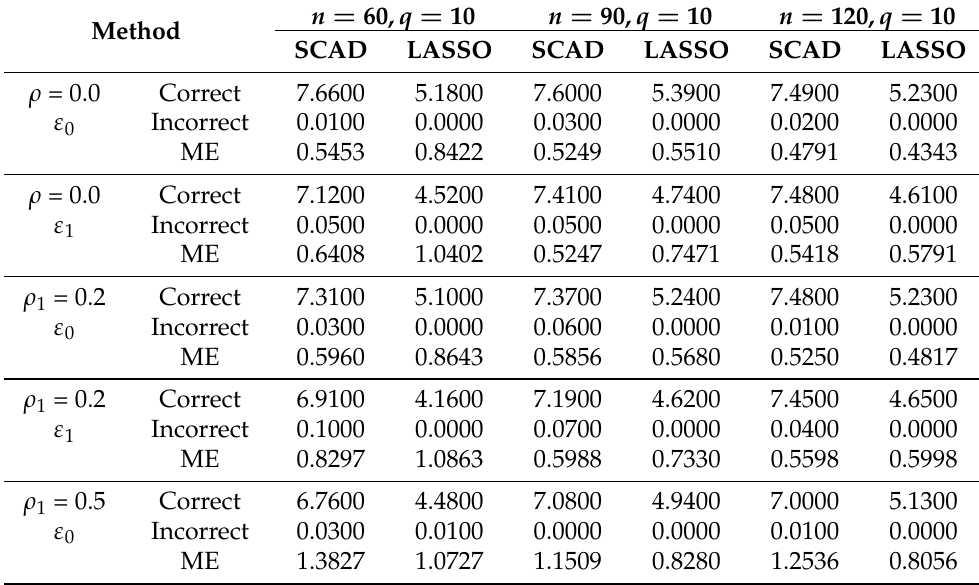
Table 5. Simulation results of variable selection when the number of components of β is